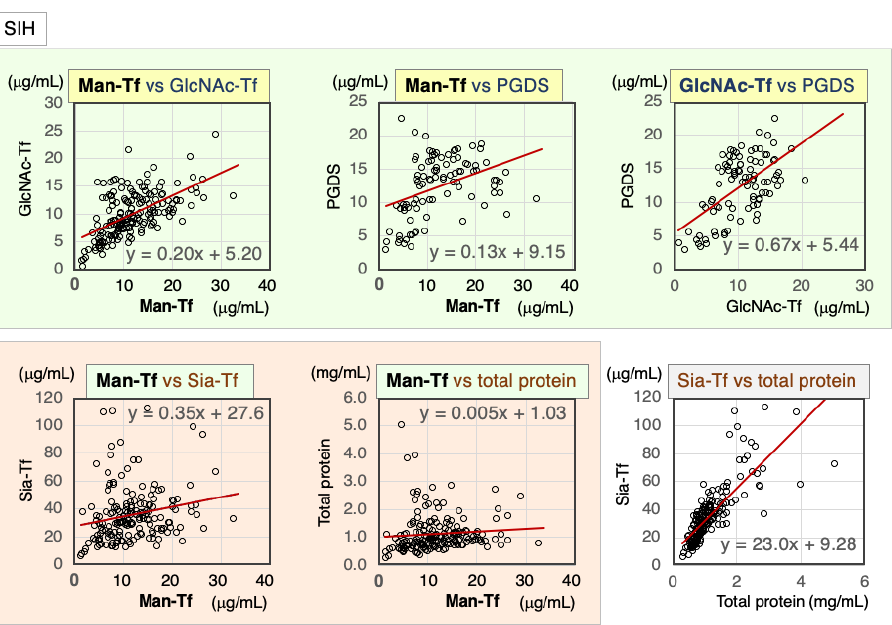
Figure 4. Scatter diagrams and regression lines for marker combinations in SIH patients. Table 3. Correlation coefficients and data normality of markers.